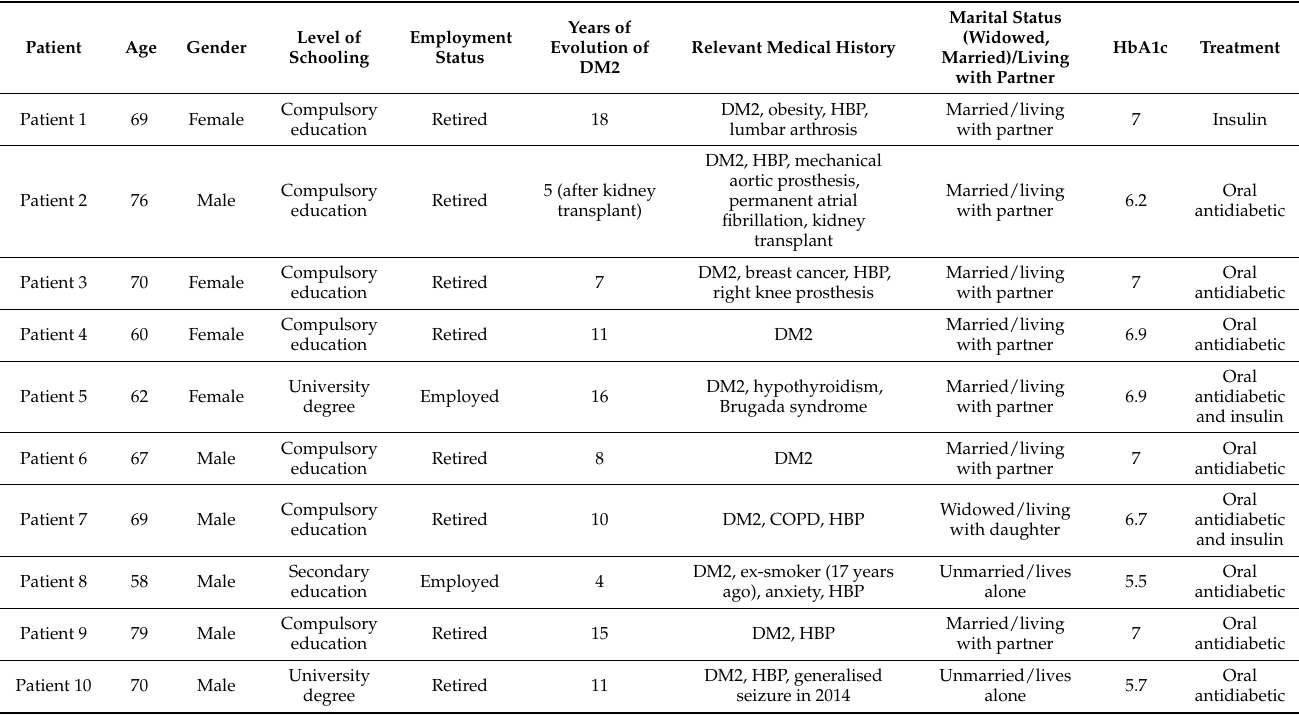
Table 1. Sociodemographic characteristics of the